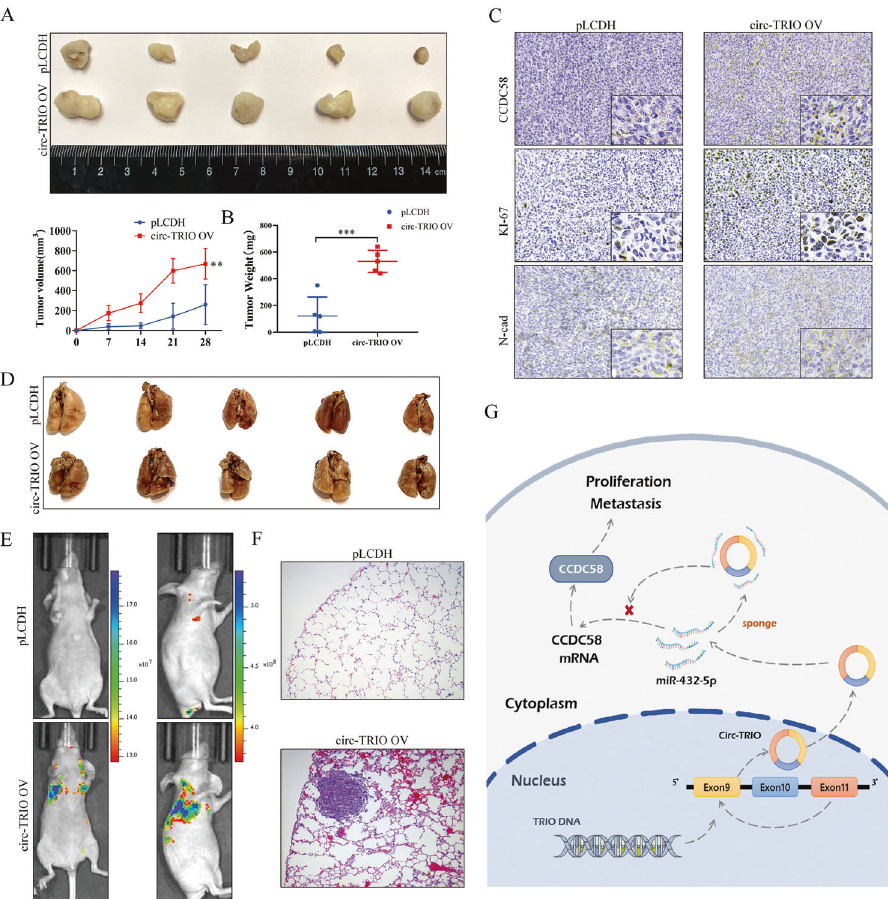
Fig. 7 Circ-TRIO facilitates the proliferation and metastasis of TNBC cells in vivo. A Upper panel, images of xenograft tumors obtained from BALB/c nude mice at the endpoint. Lower panel, growth curve of the tumor volumes, which were measured every 7 days after the initial fi rst week. B Weights of xenograft tumors at the endpoint. C CCDC58, Ki-67, and N-cad staining by IHC in xenograft tumors. D Images of lung metastatic nodules from BALB/c nude mice at the endpoint. E Animal in vivo imaging technology showing tumor metastasis. F H&E